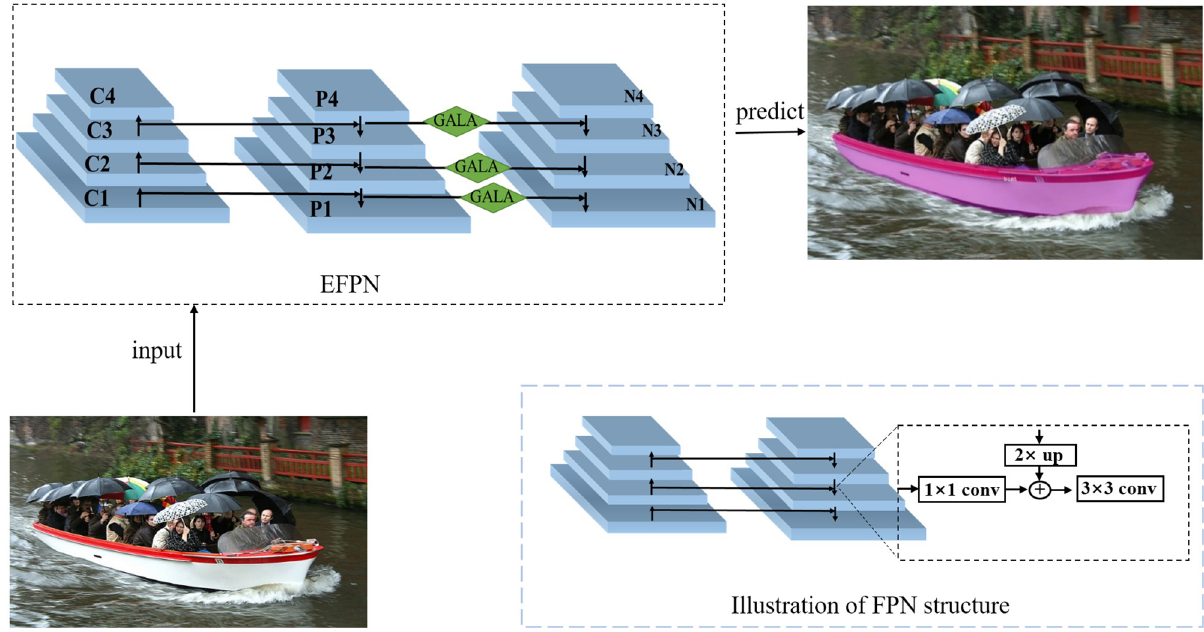
Fig 10. Schematic diagram of the enhanced feature pyramid structure. EFPN represents our enhanced improvement of the feature pyramid. GALA represents our proposed global and local attention mechanism. C1-C4 represent the feature maps of different sizes extracted from the backbone network, respectively, and P1-P4 represent the predicted objects of different scales, respectively. The original structure of the feature pyramid network is shown in the lower right.